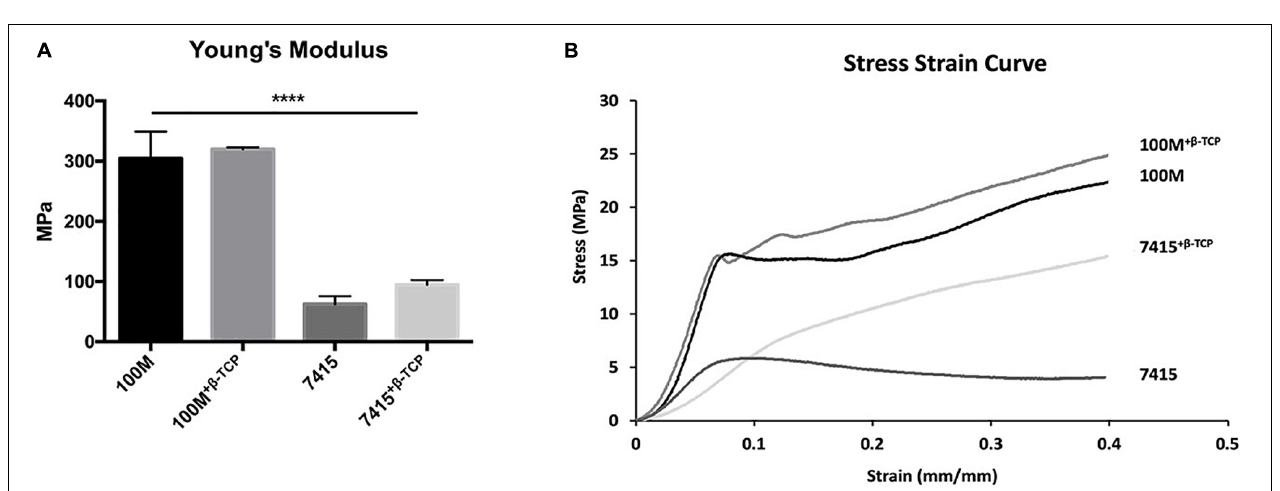
FIGURE 4 | Mechanical properties of novel 3D printed scaffolds. (A) Young’s modulus representing 5–10% compressive stress/strain curves of printed, acellular scaffolds. For each set, n = 3, error bars represent ± SD ( P -value < 0.0001). (B) Representative stress/strain curves of all materials showing the amount of deformation, elastic (proportionality) limit and plastic region. For each set, n = 3. **** p <